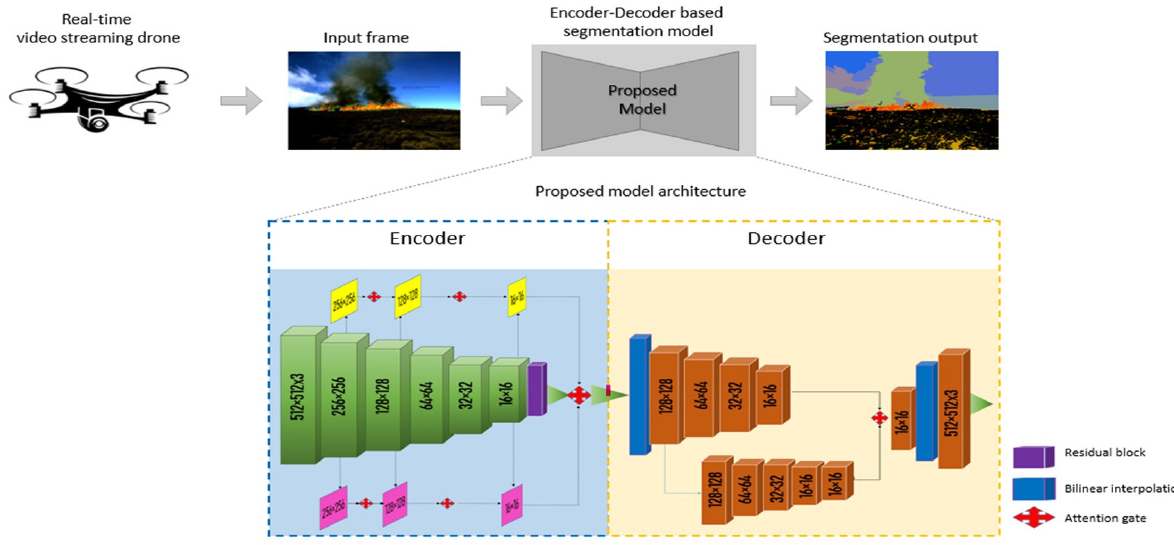
Figure 1. Overview of proposed architecture for detecting and segmenting